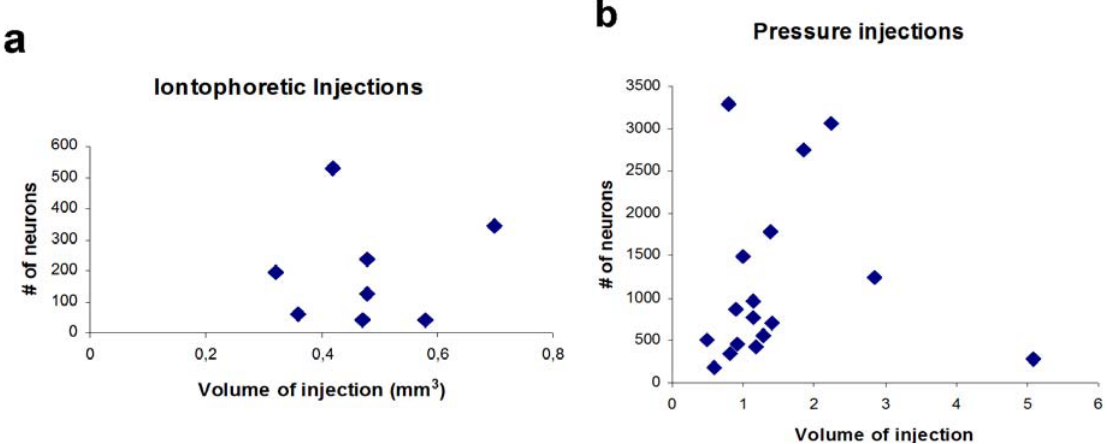
Figure 4. Correlation between numbers of retrogradely labeled neurons in the ventral hippocampus and size of the iontophoretic injection within the amygdala. ( a ) Correlation for iontophoretic injections ( n = 8). Only those injections are considered that hit the amygdala. Injections that did not hit the amygdala revealed no retrogradely labeled neurons in the hippocampus; ( b ) Correlation for pressure injection cases ( n = 17, cf. Table 1, Figure 2a). GFP-labeled neurons were more or less uniformly distributed in the ventral hippocampal